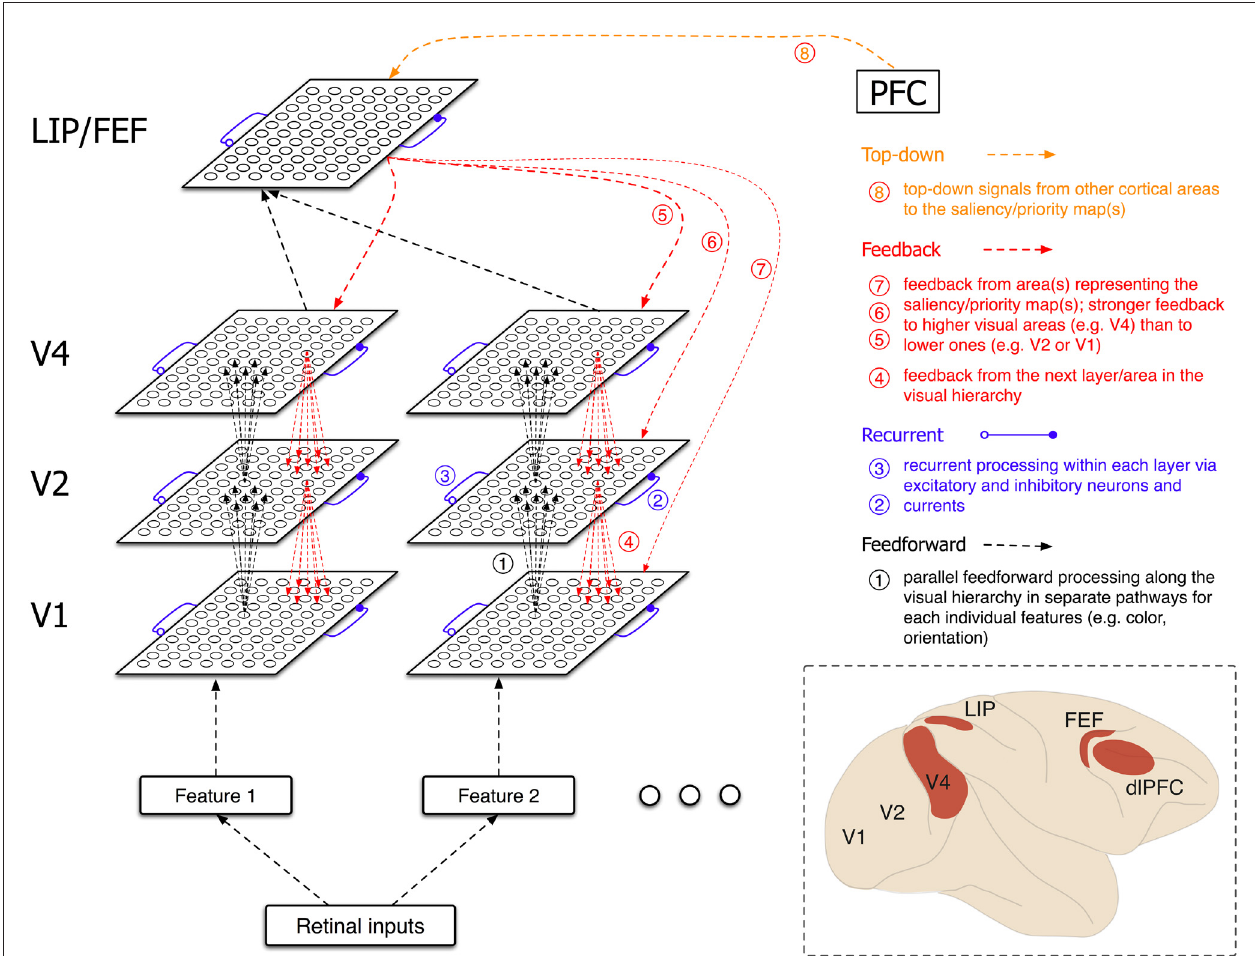
successive layers, feedback from the next layer/area in the visual hierarchy could further enhance the signals. Ultimately, outputs of different pathways are combined to instantiate the saliency/priority map(s) (possibly in area LIP and/or FEF) that represents the visual salience of the entire visual field and can determine the next attended location. Feedback from the saliency/ priority map(s) to lower visual areas could further enhance the saliency signals. Moreover, top-down signals from other cortical areas such as dlPFC could exert top-down effects and task demands on saliency computations. The inset shows a cartoon of macaque’s brain with relevant areas